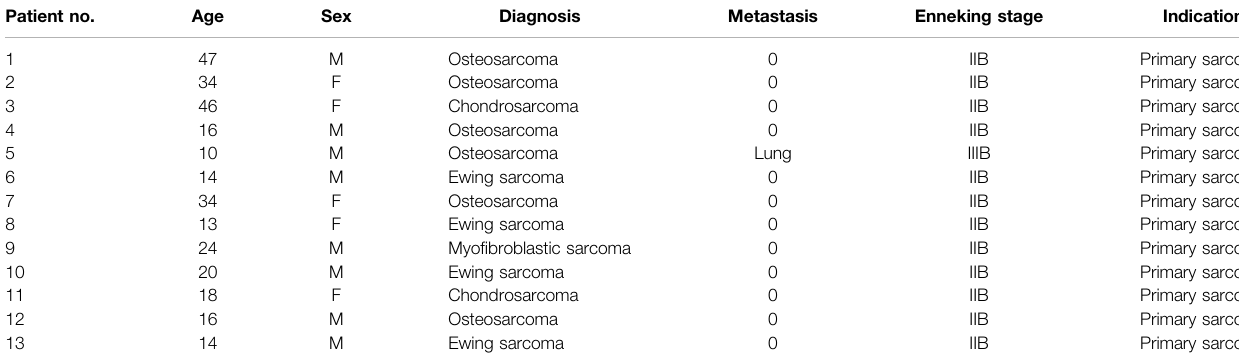
M, male; F, female.